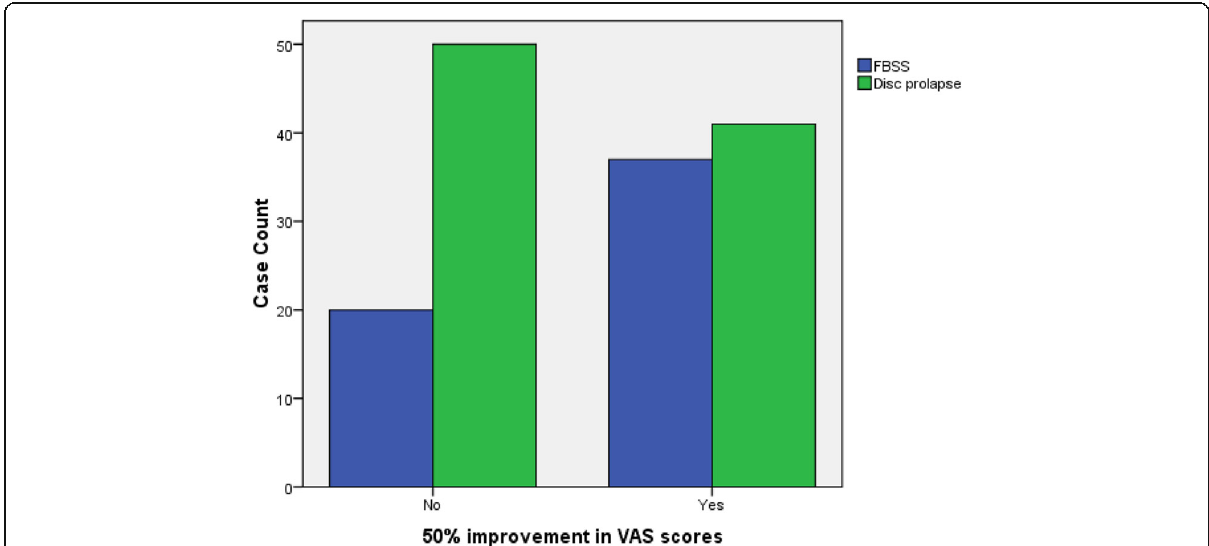
Fig. 3 A 50% or more reduction in VAS score over time in patients with FBSS and disc prolapse. VAS, visual analog scale; FBSS, failed back surgery